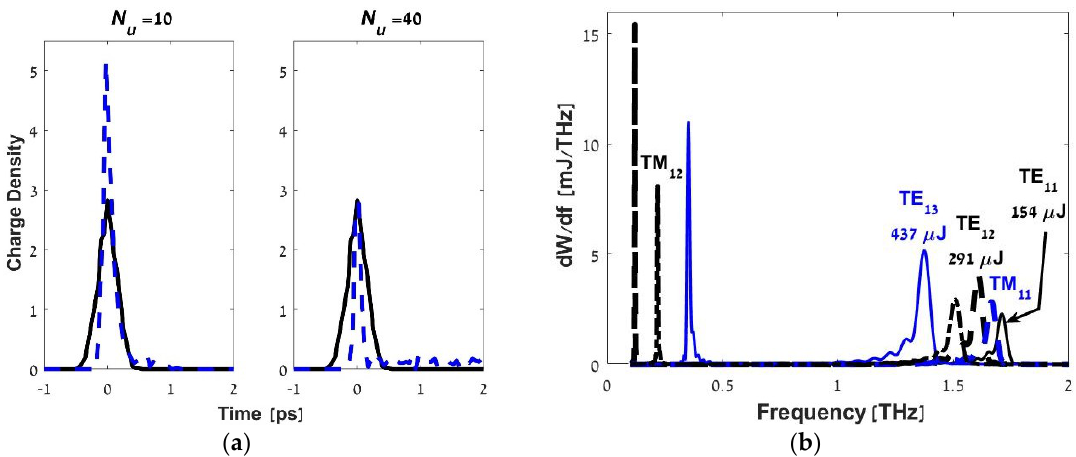
Figure 9. Multimode undulator CSR of a bunch with a diameter of 1 mm, an initial duration of 0.3 ps, a charge of 1 nC, and a particle energy of 6 MeV in the regime of simultaneous excitation of low- and high-frequency waves in a waveguide with a diameter of 10 mm: ( a ) evolution of the particle density from the initial Gaussian distribution (black curves) to distributions after 10 and 40 undulator periods (blue lines) and ( b ) emission spectrum for the undulator period d = 2.5 cm, undulator field amplitude H u = 2 kOe , and longitudinal field H 0 = 75 kOe.